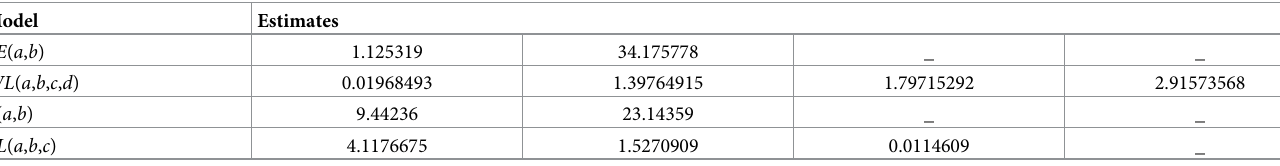
Table 3. Maximum likelihood estimates for data set 2.